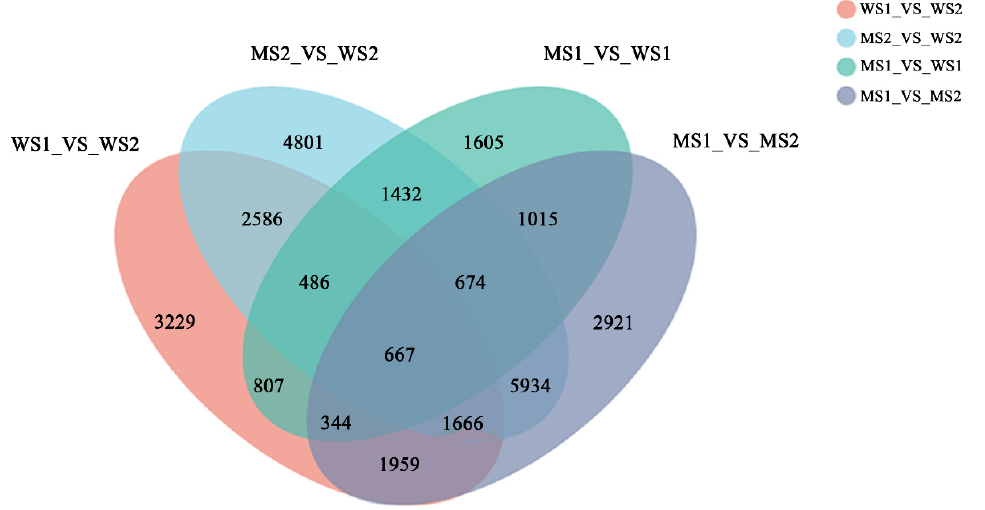
Figure 4. Venn diagram of DEG numbers in four samples. Table 4. Main enrichment pathways of DEG in 4 groups, refer to go